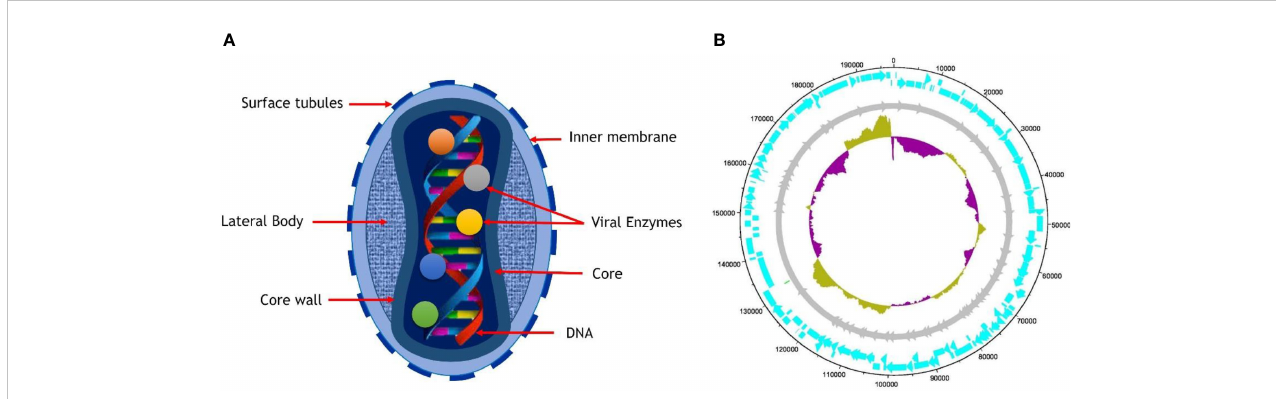
FIGURE 1 (A) Structure of mature virion of MPXV, (B) The complete genome of MPXV isolates SI2022 S7 (Genbank ID: ON838178.1) is 197652 bp long, with the length of the arrowhead representing genes (cyan) and the length of the arrow representing gene size. The dark yellow indicates that the GC content (33%) is above average, while the indigo color represents GC content below